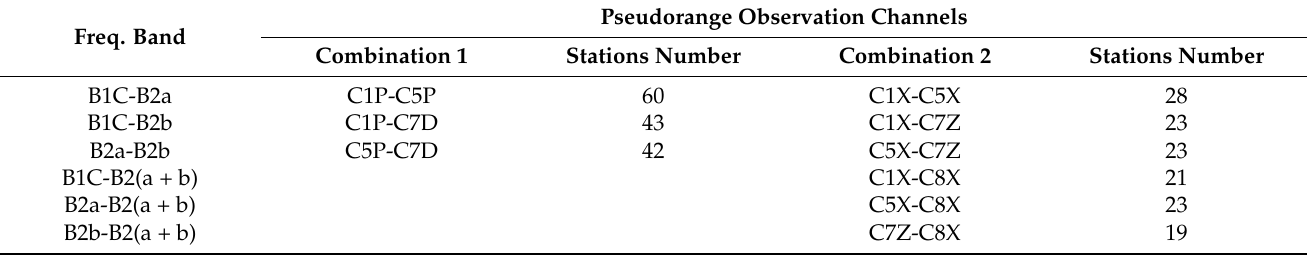
Figure 1. Distribution of MGEX stations with tracking the new BDS-3 signals. Table 2. Nine types in the DCB estimation of BDS-3.